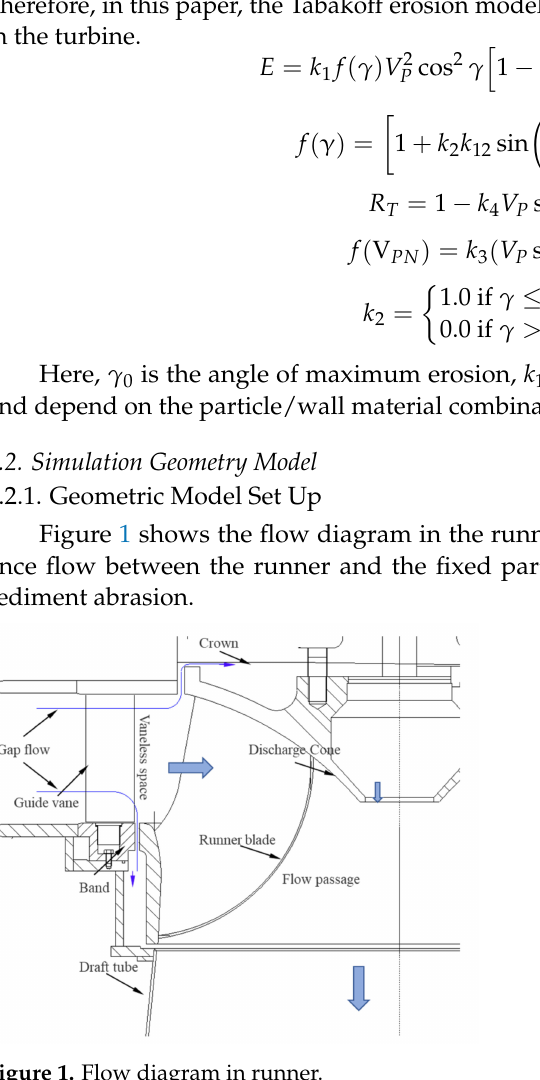
Figure 1. Flow diagram in runner.